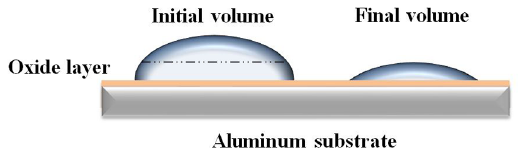
Figure 2. Schematic model of the volume variation of the semi- spherical cap produced by the drop by the action of the absorption of part of the volume